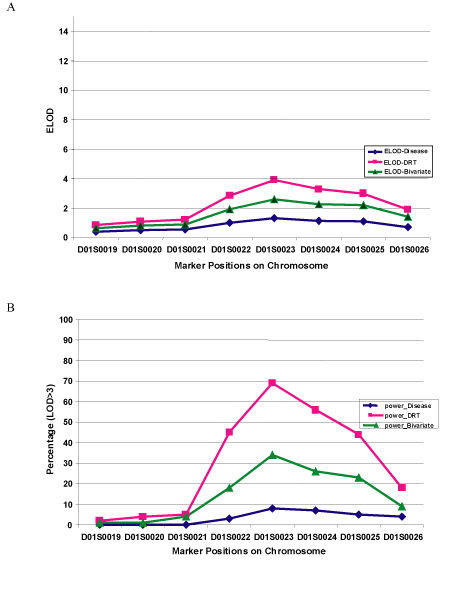
Linkage analysis of disease, DRT, and bivariate trait with the Aipotu dataset: ELOD (A) and power (percentage (LOD>3)) (B).